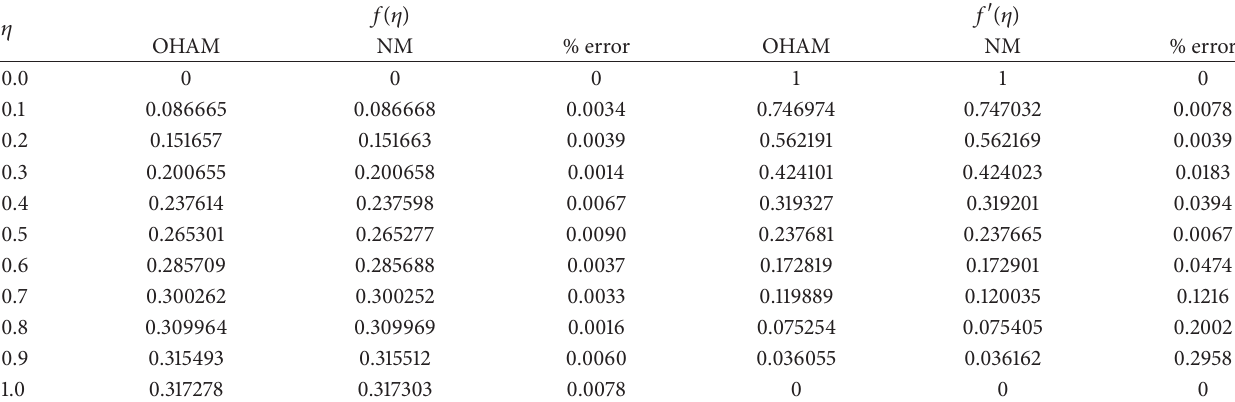
Table 1: Comparison of OHAM results with numerical method for 𝐾 = 0 , 𝛽 = 5 , and 𝑀 = 5